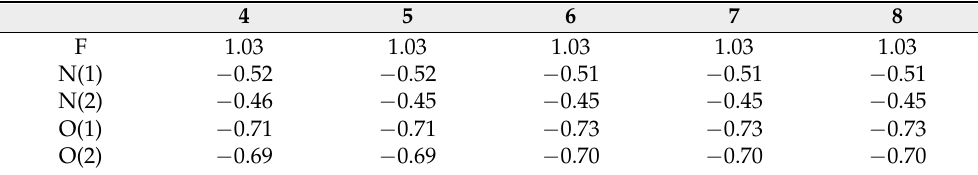
Table 2. Computed NAO charges within the nickel coordination